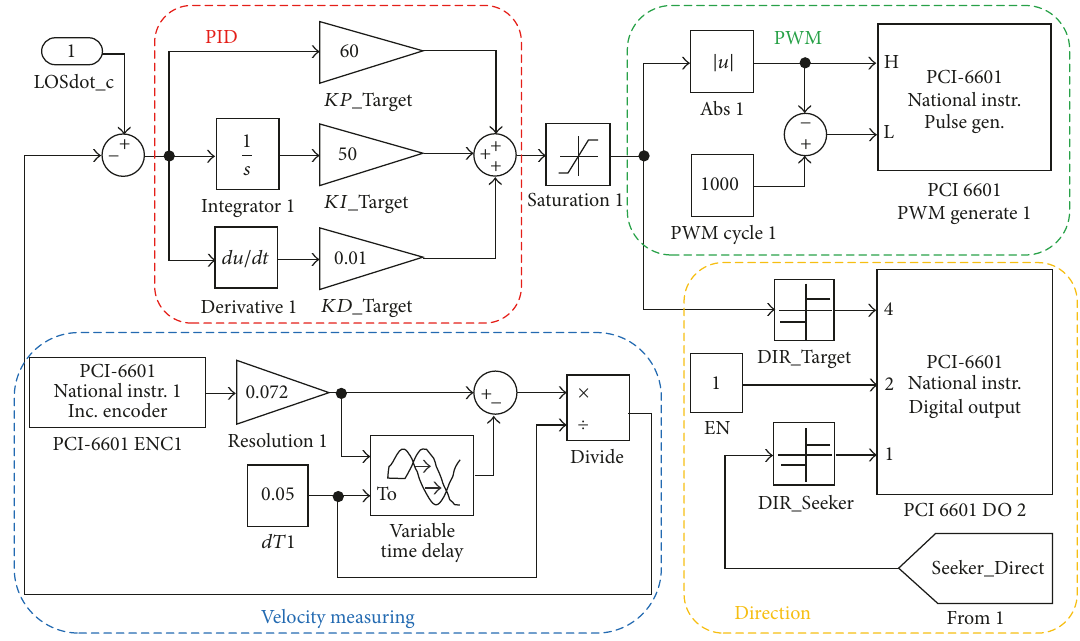
Figure 10: Target_Motor